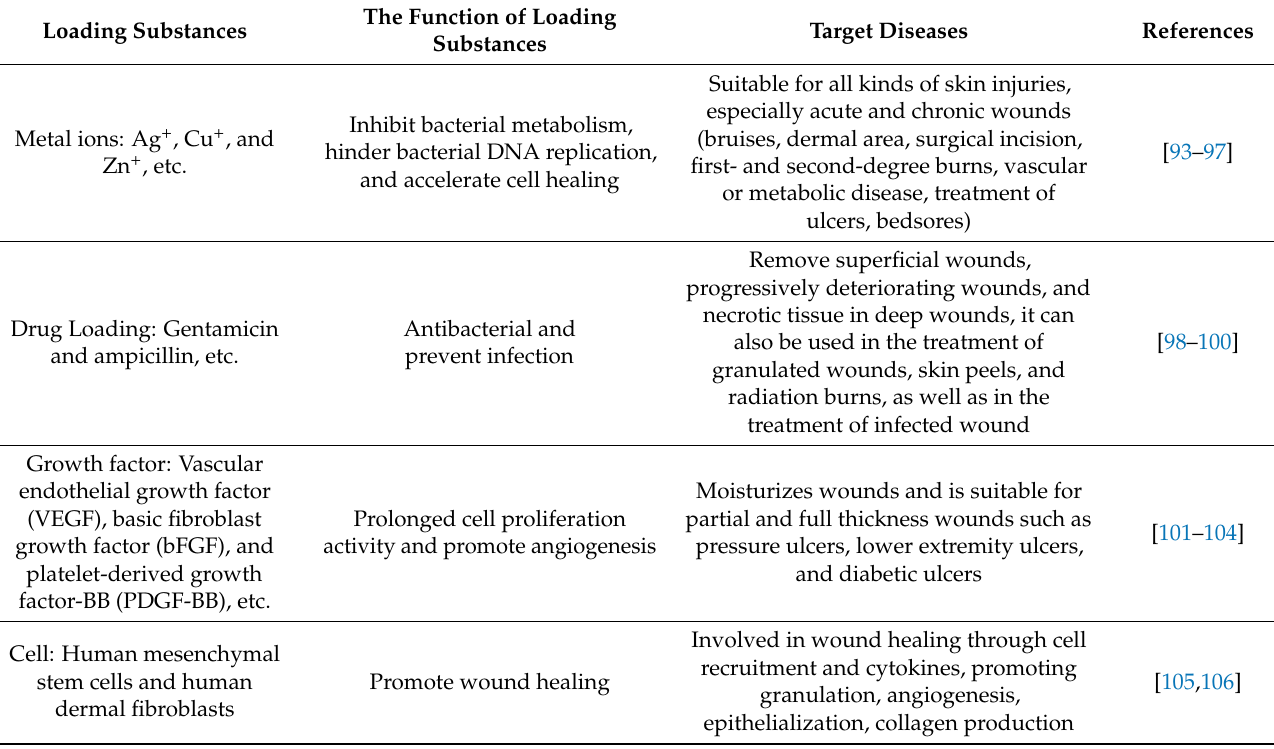
Table 1. Loading substances of hydrogels and their